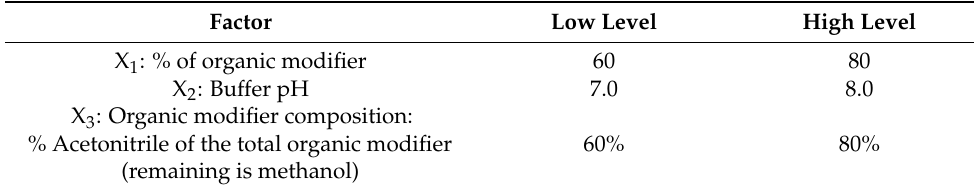
Table 6. Lower and higher levels of the optimization design for simultaneous separation of CAR and its